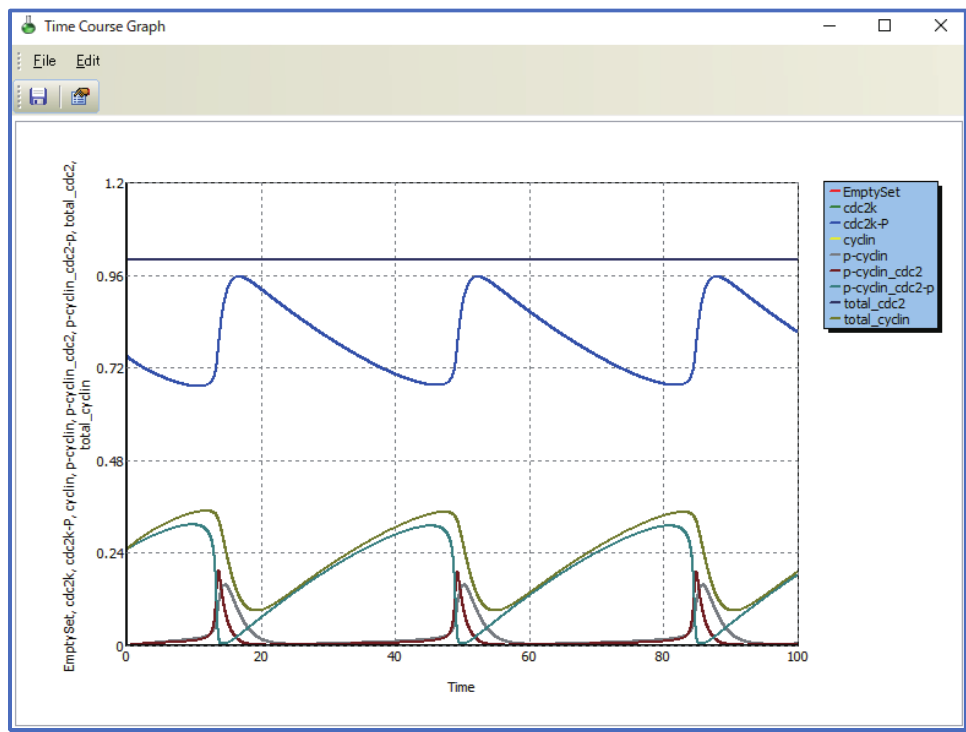
Figure 12. A reaction scheme created from multiple layers can be simulated as a single integrated model, even if it contains algebraic